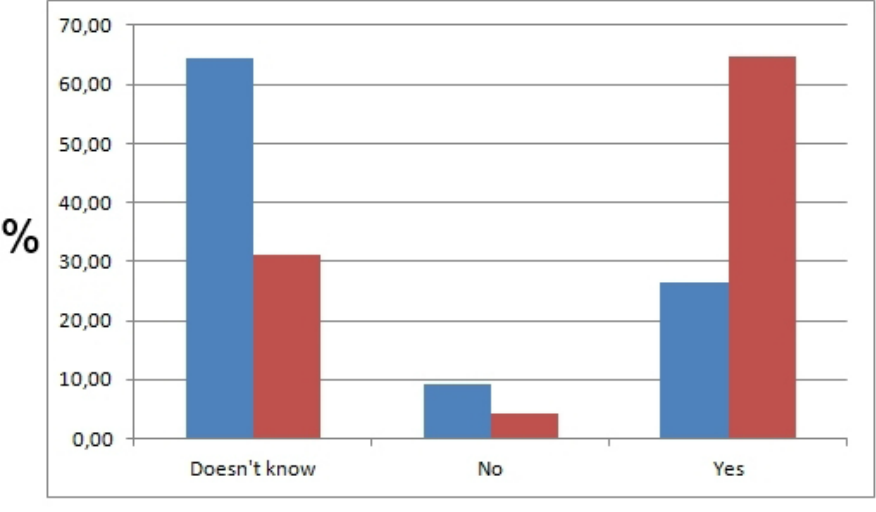
Figure 4. Whether the students believe they will meet the special needs of e-patients. The y axis represents the percentage of students that chose the particular answer. Blue and red bars represent responses acquired before and after the course,